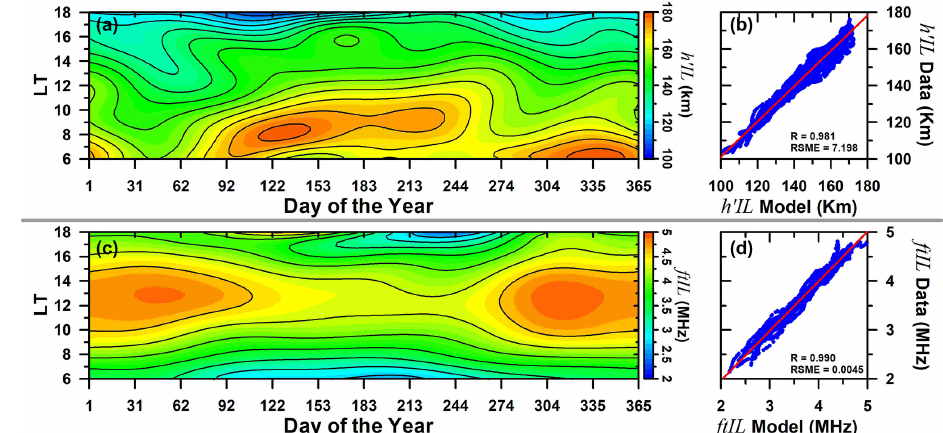
Figure 4. Contour plot of the annual variation of the modeled virtual height (h’IL, a ) and top frequency (ftIL, c ) of the intermediate layers over Cachoeira Paulista. The dispersion diagrams on the right-hand side show the correlation between the weighted arithmetic mean and model results. In (b) and (d) , the correlation coefficient ( R ) and root mean square error (RSME) values are also provided.